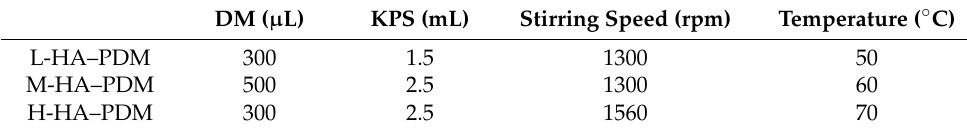
Table 3. Optimum process and formulation